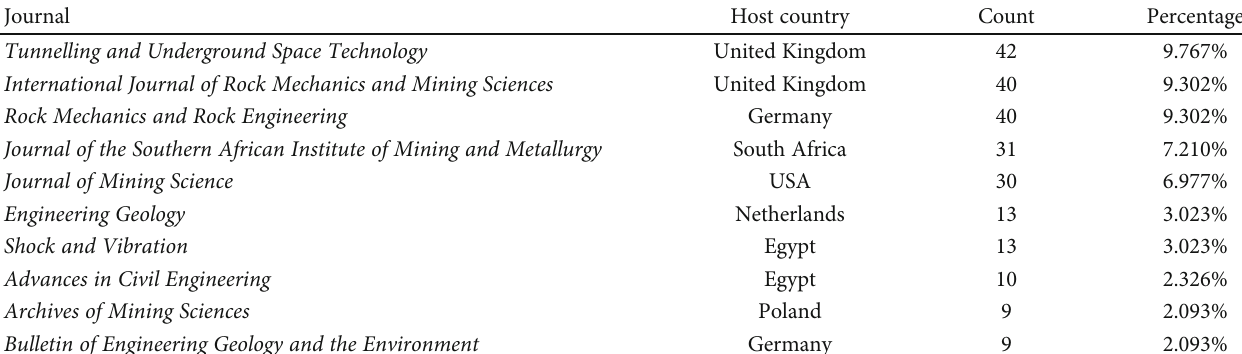
Table 3: Top 10 journals in terms of publication number.